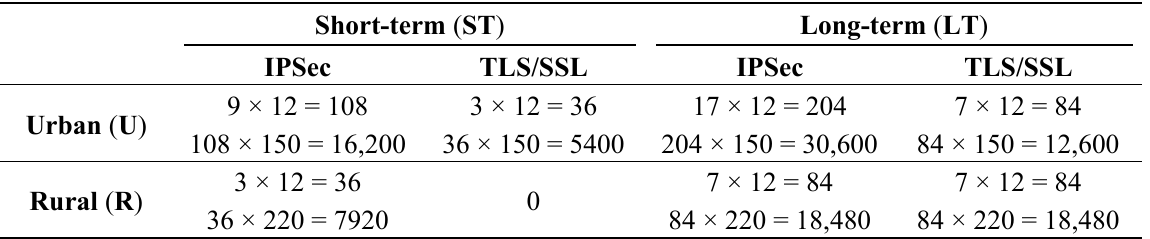
Table 7. Difference of cost (in €) per CNTR and per district during one year between using FF and using Aggr in each scenario.